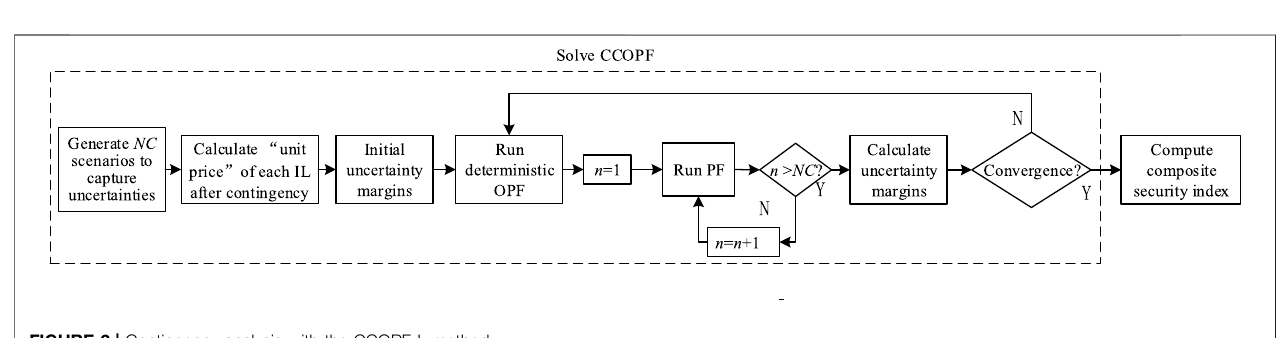
FIGURE 2 | Contingency analysis with the CCOPF-L